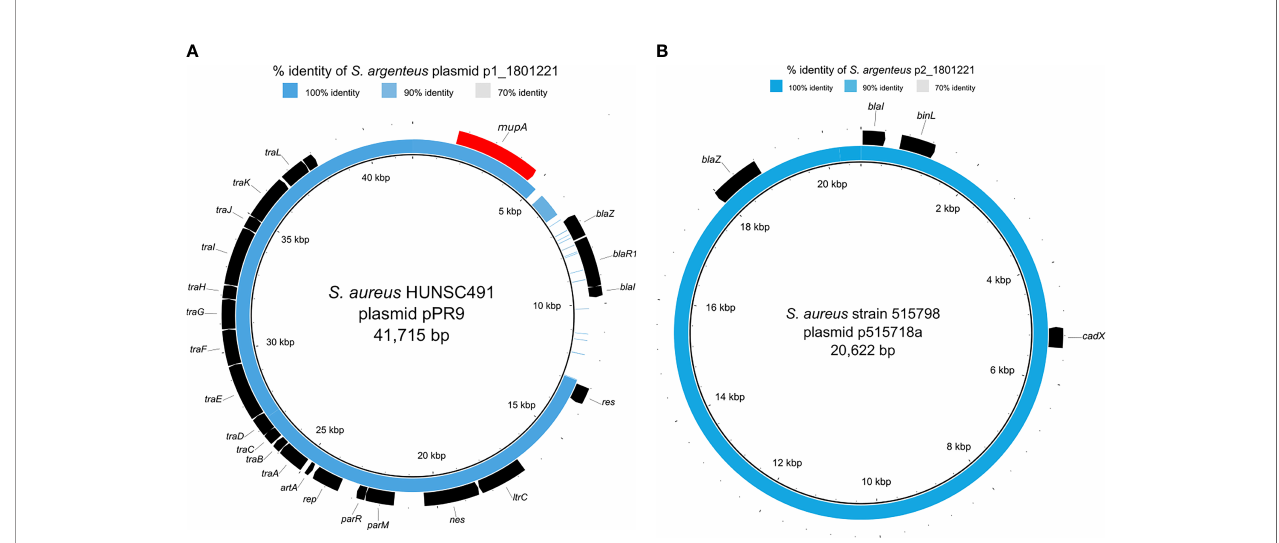
FIGURE 3 | Comparison of S. argenteus plasmids with closely related S. aureus plasmids. The inner black ring represents the reference sequence, and the blue ring depicts the respective S. argenteus plasmid sequence. The outer black ring provides annotation information, i.e., detected ORFs, where the annotation resulted in known genes. The blue color ’ s intensity is related to the sequence similarity, detailed in the Supplementary Table . (A) depicts the comparison of p1_1801221 and the conjugative S. aureus plasmid pPR9 harboring the mupA gene encoding for mupirocin resistance (colored in red); (B) shows the comparison of p2_1801221 and the S. aureus plasmid p515718a harboring blaZ and cadX encoding for beta-lactam and cadmium resistance,